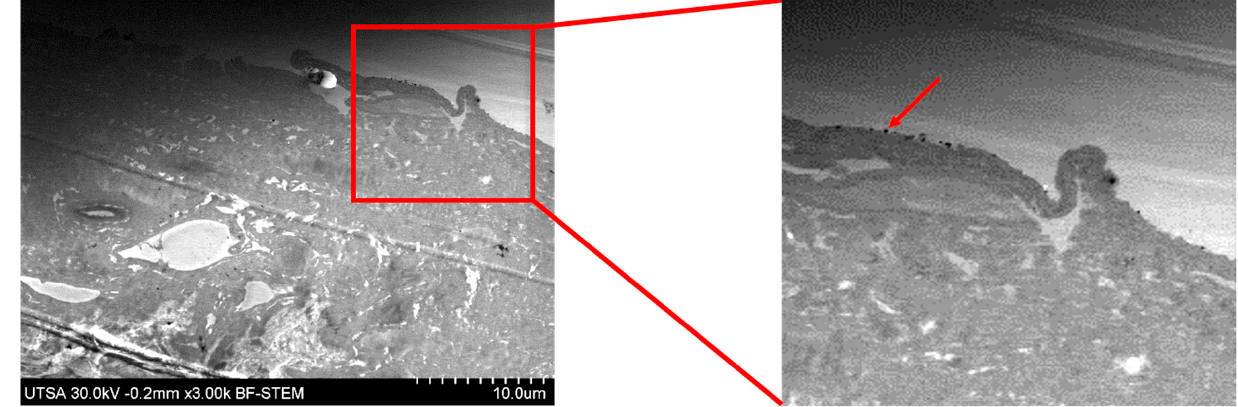
Figure 5. Porcine skin image by STEM. The red arrow shows AgNPs on the skin